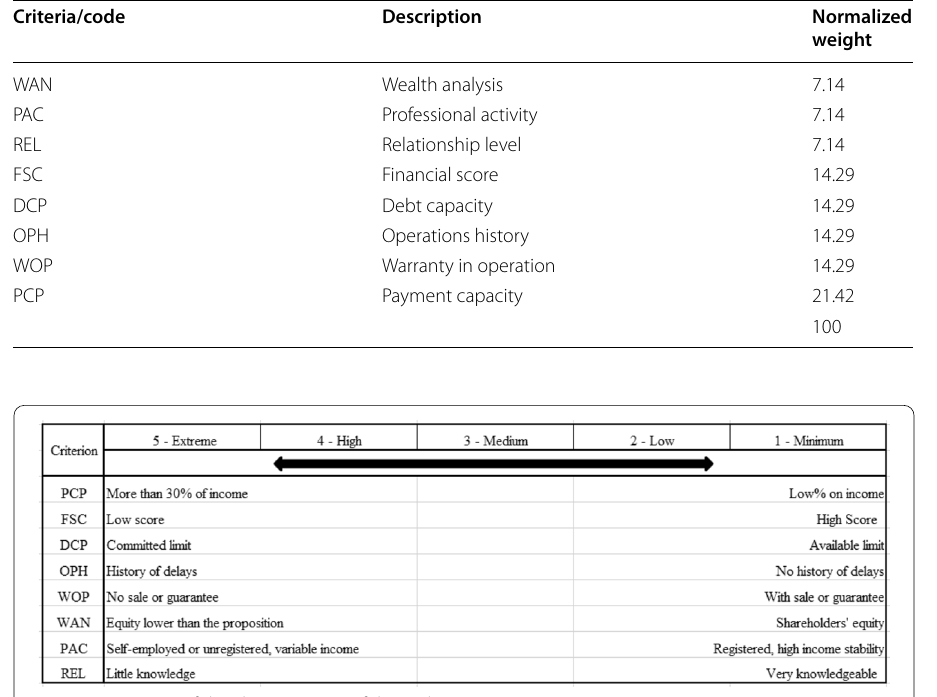
Fig. 2 Continuum of the characteristics of the